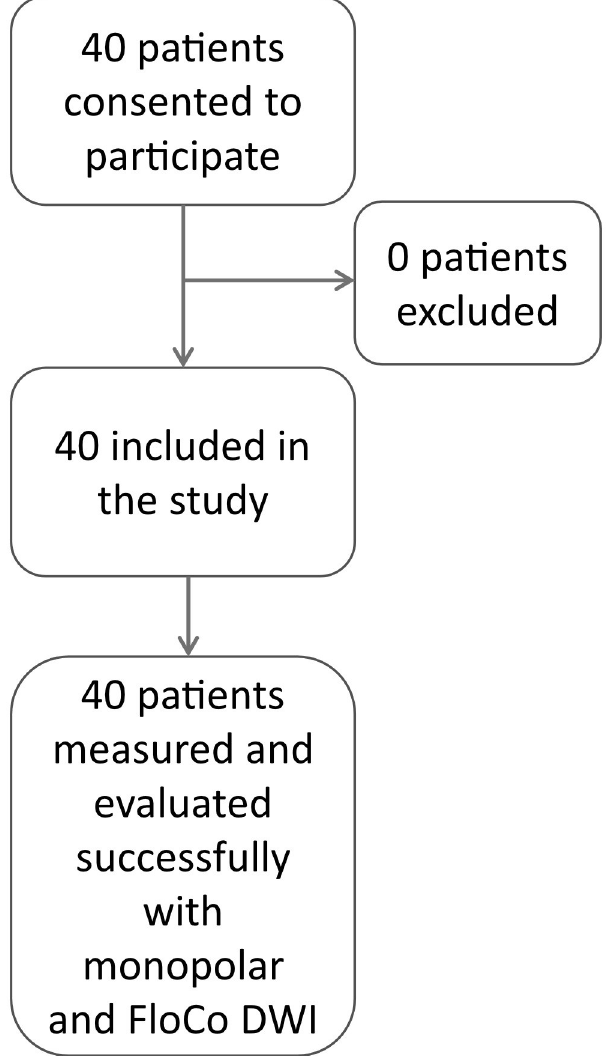
Fig 1. Participant flow diagram. Footnote: FloCo = Flow-compensated. DWI = diffusion-weighted imaging.